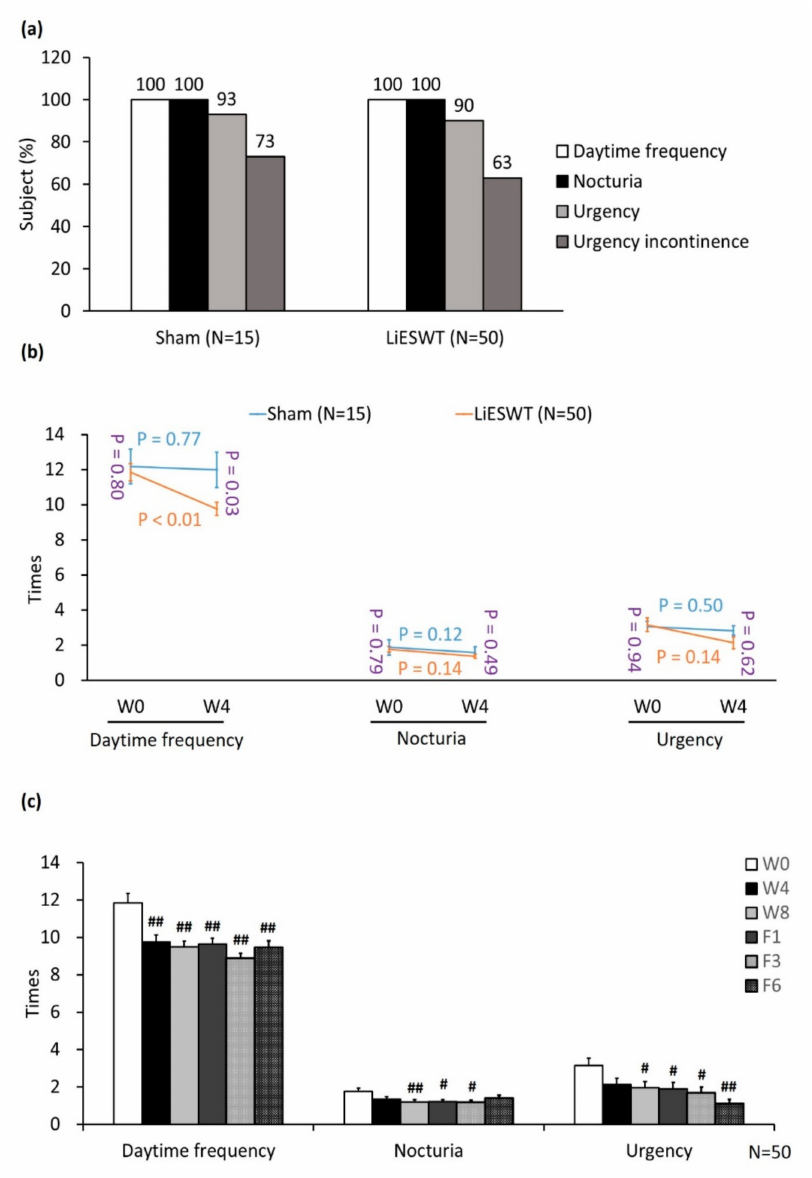
Figure 2. Analysis of studied population with OAB symptoms. ( a ) The percentage of studied population with OAB symptoms. OAB symptoms consisted of daytime frequency, nocturia, and urgency with or without urgency incontinence. ( b ) The changes in daytime frequency, nocturia and urgency at W4, as compared with W0. The blue or orange font denotes the p -value before and after 4 weeks treatment in the sham group or in the LiESWT-treated group, respectively. The purple font indicated the p -value between the sham group and the LiESWT-treated group at W0 and W4. ( c ) LiESWT improved the OAB symptoms. The mean values of daytime frequency, nocturia and urgency were meaningfully decreased after LiESWT treatment at W8. W0: the baseline, W4: 4-week of LiESWT treatment, W8: 8-week of LiESWT treatment, F1: 1-month follow-up, F3: 3-month follow-up, F6: 6-month follow-up. # p < 0.05; ## p < 0.01 as compared with